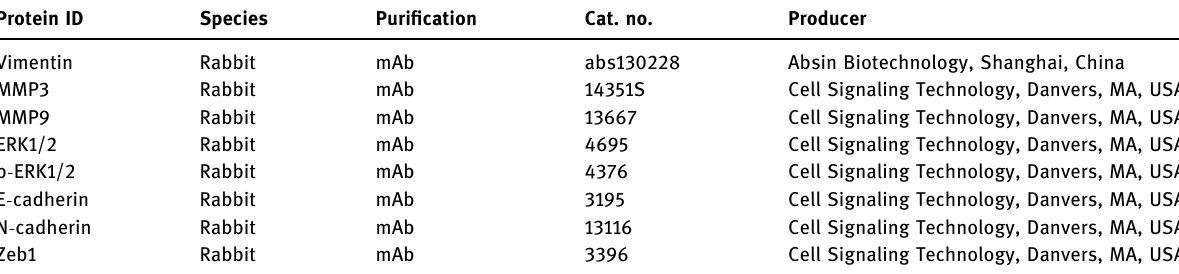
Table A1: Antibody information datasheet